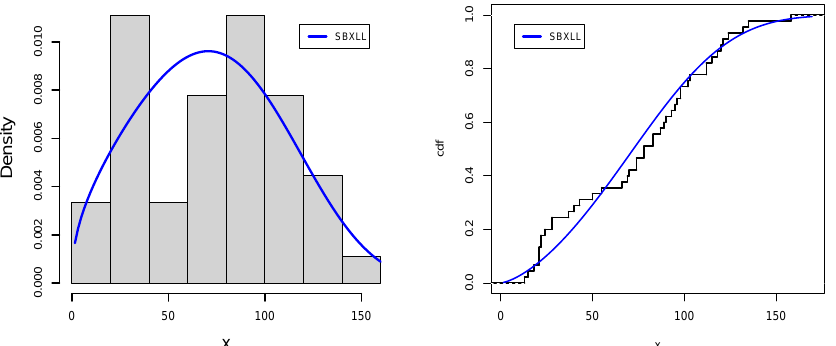
Figure 10. Plots of estimated pdf and cdf of the SBXLL model for data